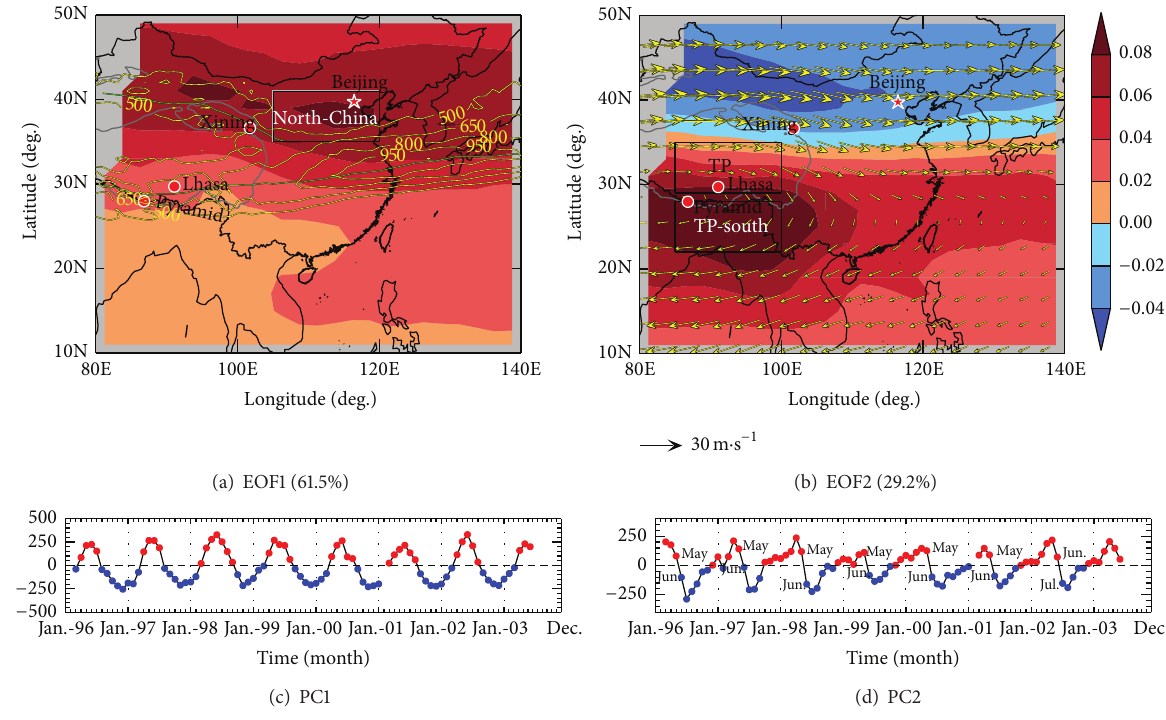
Figure 4: Two dominant patterns retrieved from EOF analysis ((a) EOF1, (b) EOF2) of monthly mean TOVMR (color shaded) and their corresponding time series ((c) PC1, (d) PC2; red: positives, blue: negatives) between March 1996 and June 2003. The yellow contours in (a) are total westerly jet occurrence counts based on 6-hourly ERA-interimdata, and thethick green lines showthepositionof maximum occurrence. Summer (June–August) winds at 200 hPa for the same period are shown by vectors in (b). The red star is the location of Beijing and the red dots are locations of Lhasa, Xining, and Pyramid (Nepal); they are four ozonesonde stations. The square in (a) is the area of northern China; the square in (b) is southern Tibetan Plateau and the area to the south of Tibetan